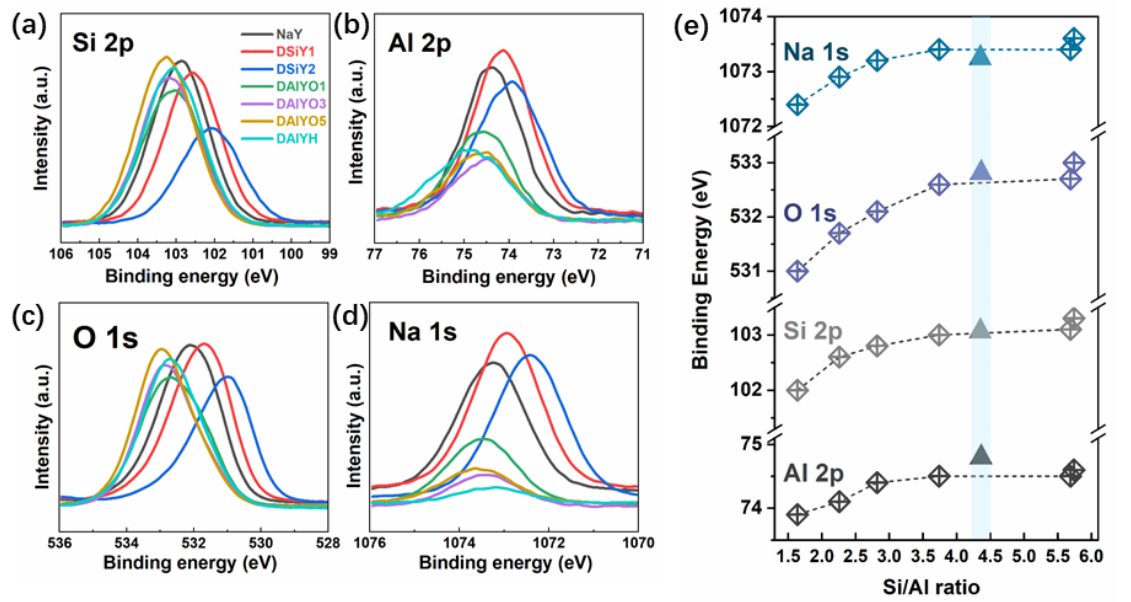
Figure 2. XPS spectra for Si 2p ( a ), Al 2p ( b ), O 1s ( c ), and Na 1s ( d ) in NaY, DSiY1, DSiY2, DAlYO1, DAlYO3, DAlYO5, and DAlYH. Summary of the Si/Al ratio dependence of BE, in which the triangles represent for the data for DAlYH ( e ). Table 1. XPS data of elemental composition of the parent NaY zeolite, and the desilicated and dealuminated zeolites.